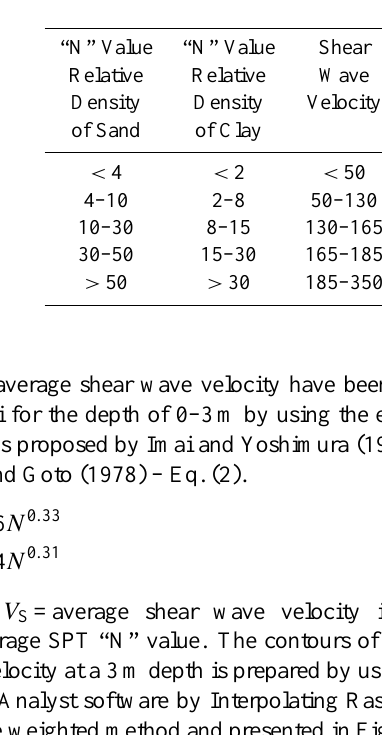
Table 2. “N” value V S shear wave